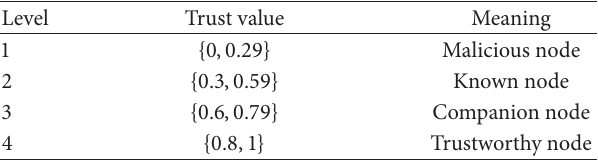
Table 1: Trust levels of